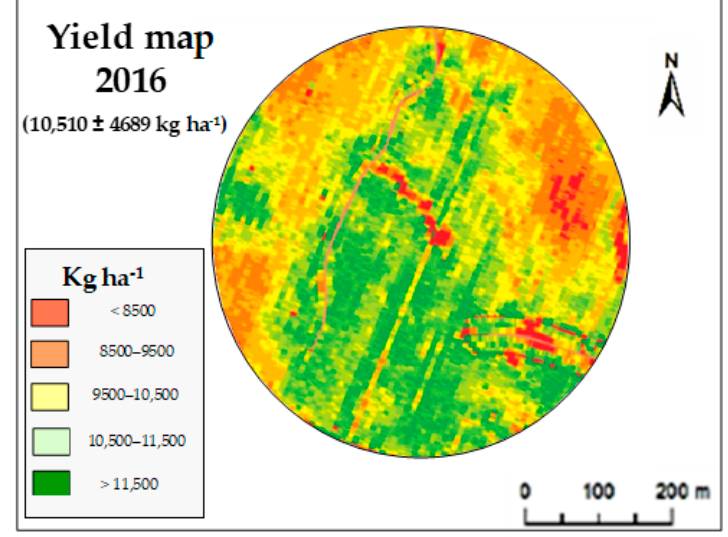
Figure 4. Corn yield map of a “Eucalyptus” field in October 2016.